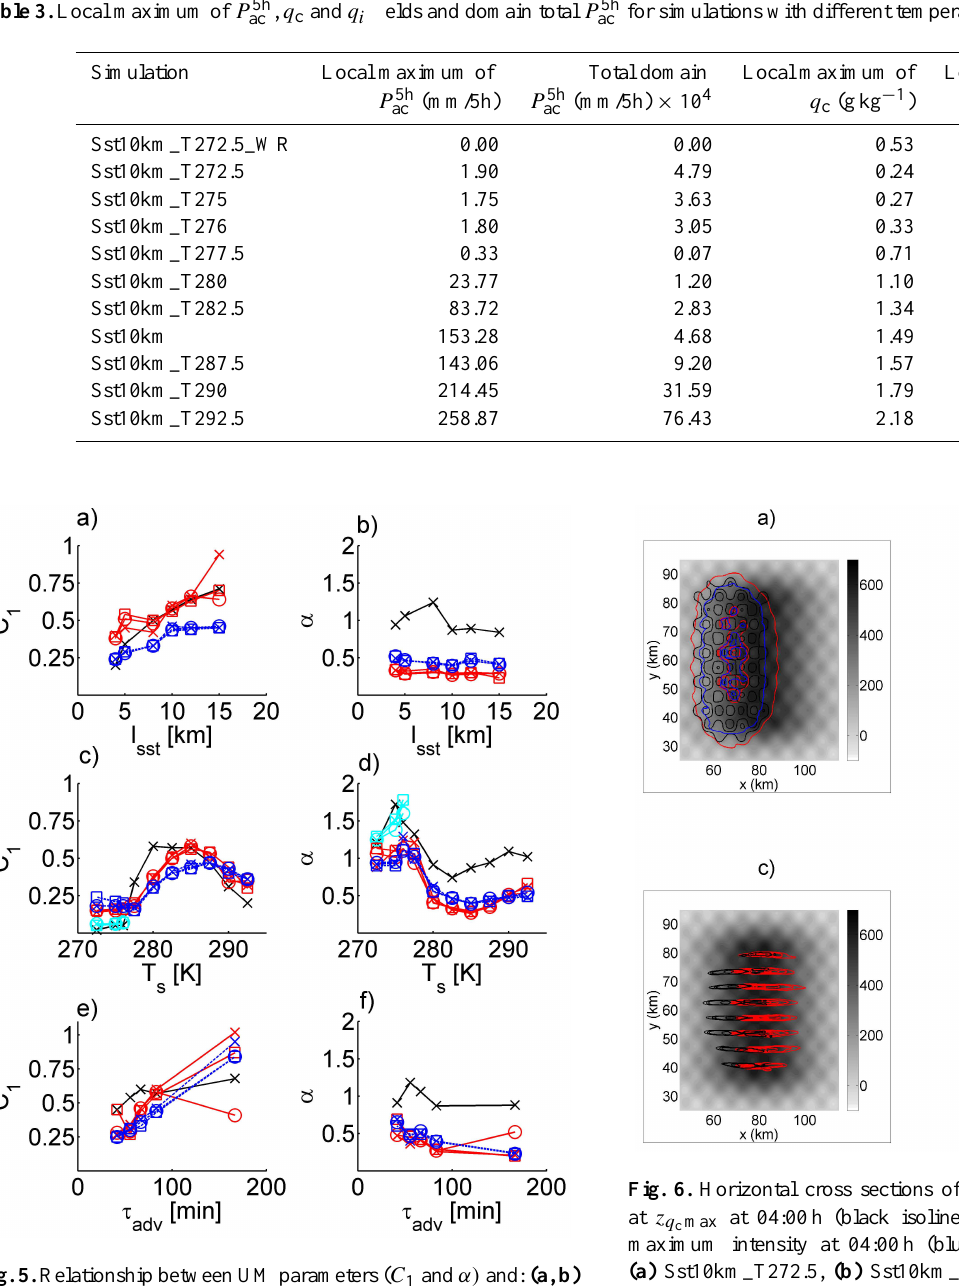
Fig. 5. Relationship between UM parameters ( C 1 and α) and: (a, b) l sst ; (c, d) T s ; and (e, f) τ adv . Black lines represent values computed from P 5h ac , red and blue lines are computed from q c at z q z = 1100m, respectively. Light blue markers are computed from ice mixing ratio fields at the level of their maximum intensity. “x”, “o”, “ (cid:3) ” markers represent simulation times 05:00h, 04:00h and 03:00h, respectively.